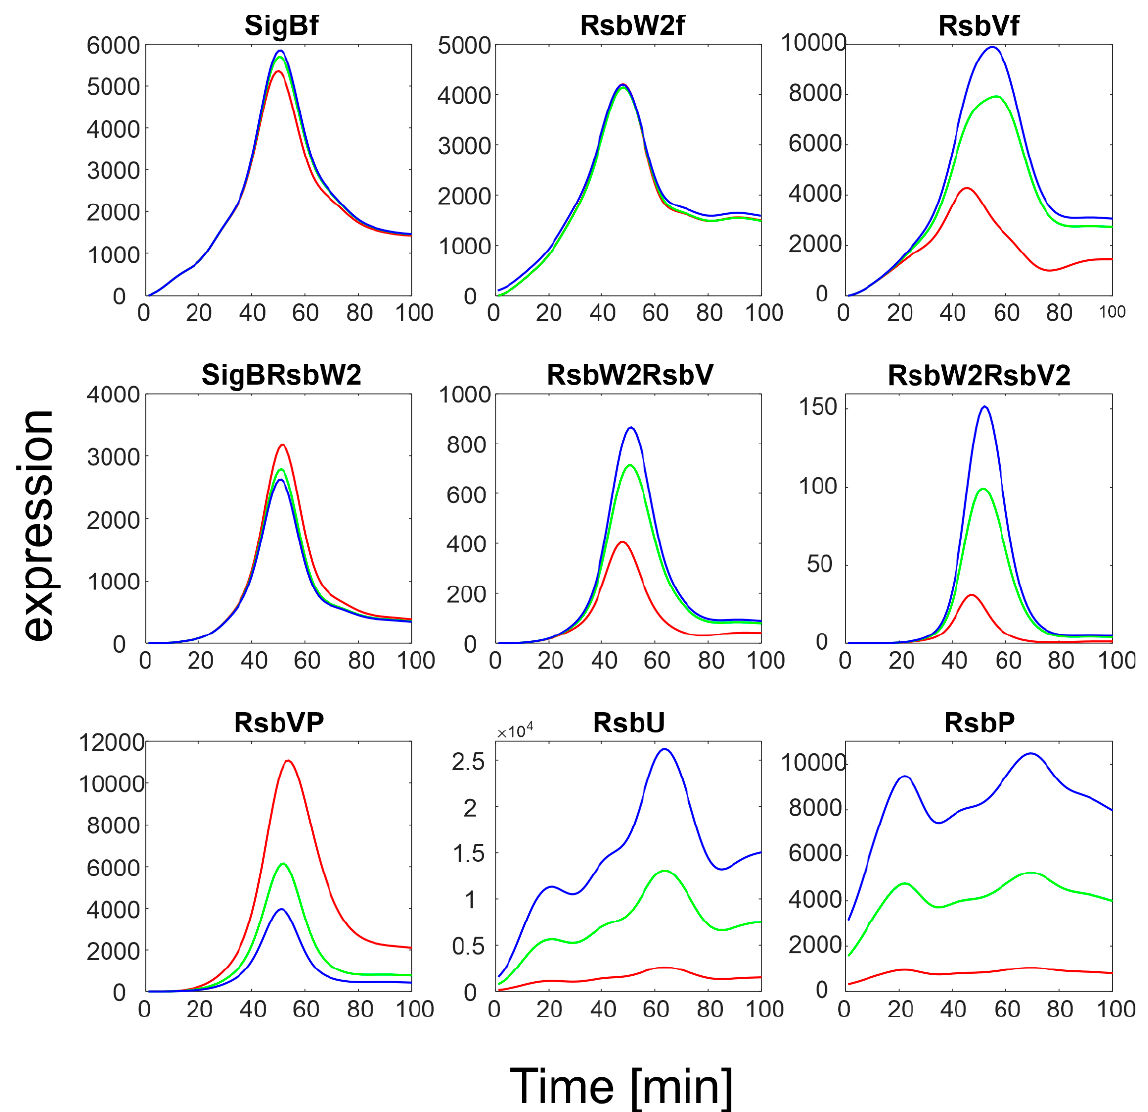
Figure 4. Results of simulation of SigB regulatory network with increasing expression of RsbU/RsbP. Red line represents original measured values of RsbU/RsbP and the resulting expression of the remaining members of the network. Index f-free form of the factor. Green and blue lines are 5 and 10 multiples of the red line for RsbU/RsbP, which served as input variables, respectively.